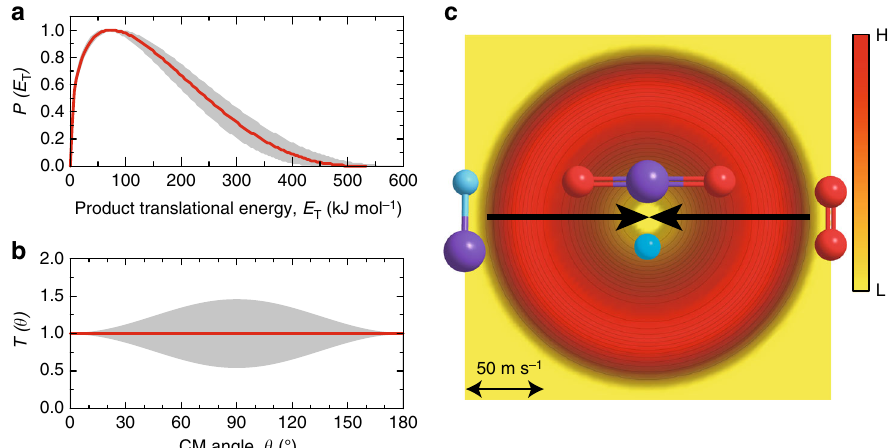
Fig. 2 Center-of-Mass (CM) distributions and the associated fl ux contour map. CM translational energy fl ux distribution ( a ), CM angular fl ux distribution ( b ), and the top view of their corresponding fl ux contour map ( c ) leading to the formation of silicon dioxide plus atomic deuterium in the reaction of D1- silylidyne with molecular oxygen. Shaded areas indicate the error limits of the best fi ts accounting for the uncertainties of the laboratory angular distribution and TOF spectra, with the red solid lines de fi ning the best- fi t functions. The fl ux contour map represents the fl ux intensity of the reactive scattering products as a function of the CM scattering angle ( θ ) and product velocity ( u ). The color bar indicates the fl ux gradient from high (H) intensity to low (L) intensity. Colors of the atoms: silicon (purple), oxygen (red), and deuterium (light